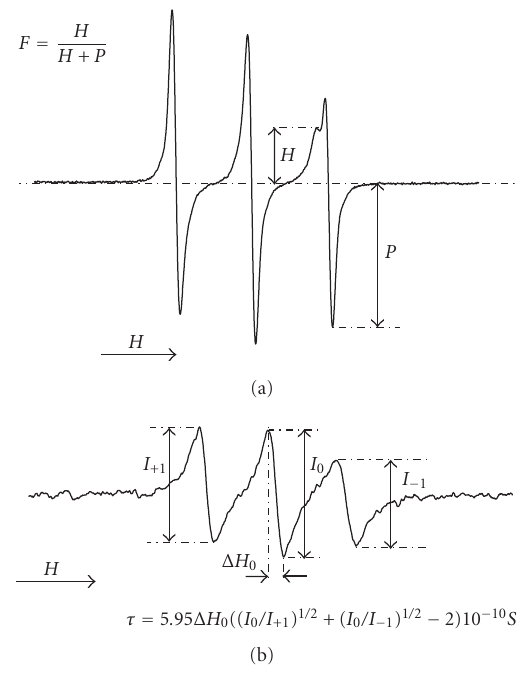
Figure 2: ESR spectra of spin probes placed in the membrane of EYL liposome; (a) TEMPO probe, (b) 16-DOXYL- stearic acid methyl